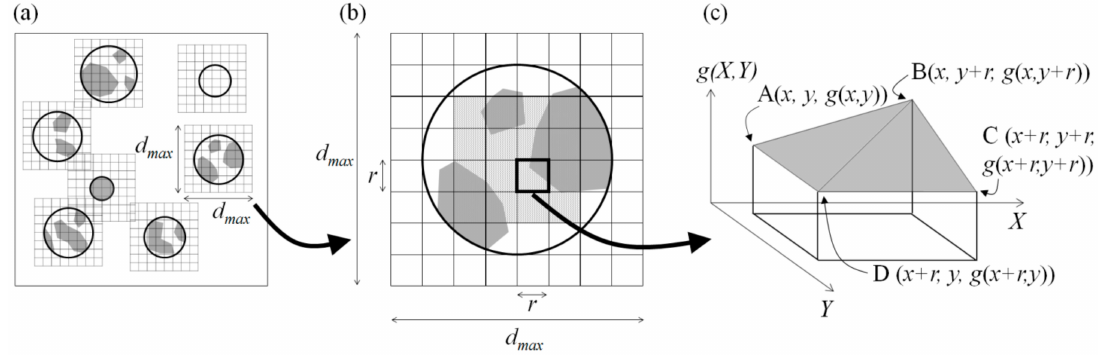
Figure 5. Fractal dimension calculation procedure: ( a ) superimposition of a square with particle sections of size d max ; ( b ) even subdivision of the square into small squares of size r ; and ( c ) calculation of the surface area of an imaginary 3D structure with height proportional to the image intensity